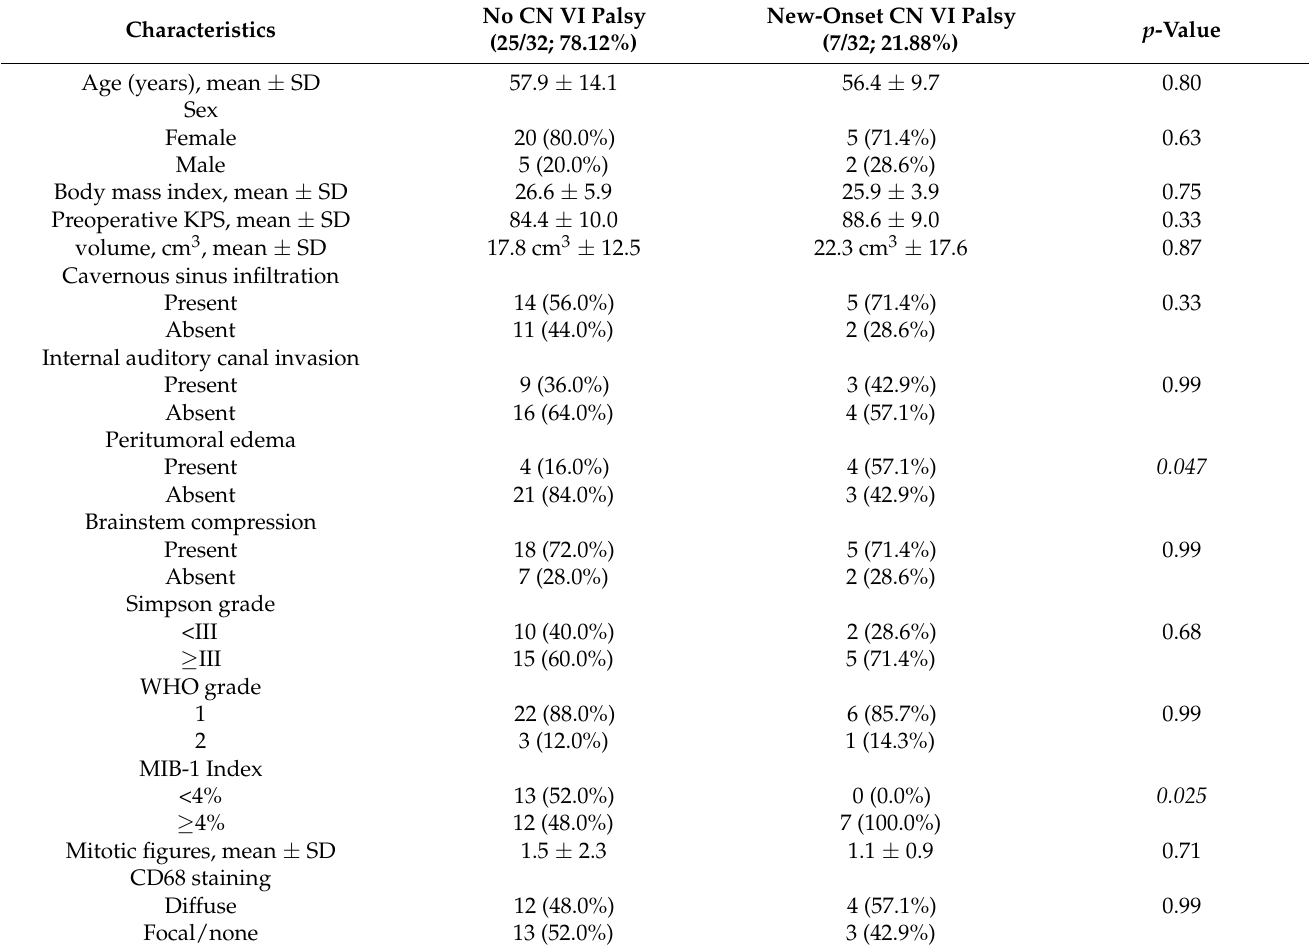
Table 3. Comparison of patient characteristics in groups with or without new-onset abducens nerve palsy after semi-sitting surgery via retrosigmoid approach for primary petroclival meningioma (using Fisher’s exact test (two-sided) and independent t -test). p -values in italic represent statistically significant